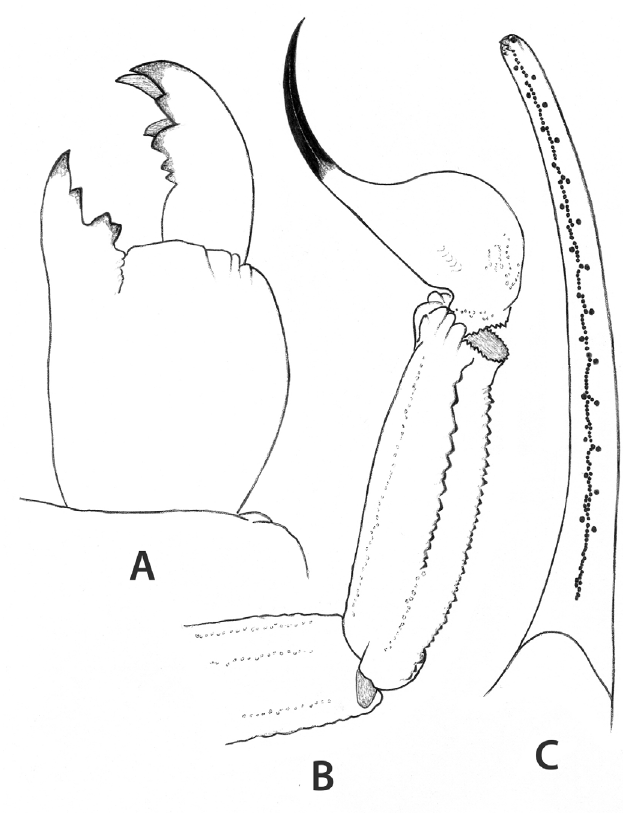
Figure 4. Leiurus dekeyseri sp. n. Female holotype. (A) Chelicera, dorsal aspect. (B) Metasomal segment V and telson, lateral aspect. (C) Cutting edge of movable finger, showing rows of